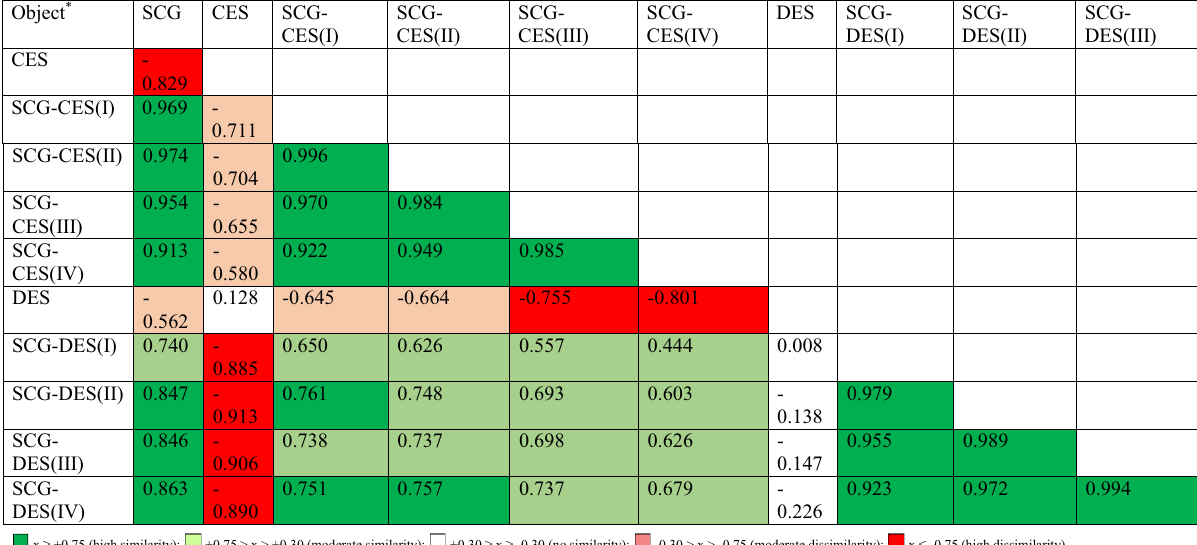
Table 4. Mineral profile comparative analysis (Cohen’s profile similarity coefficient) for